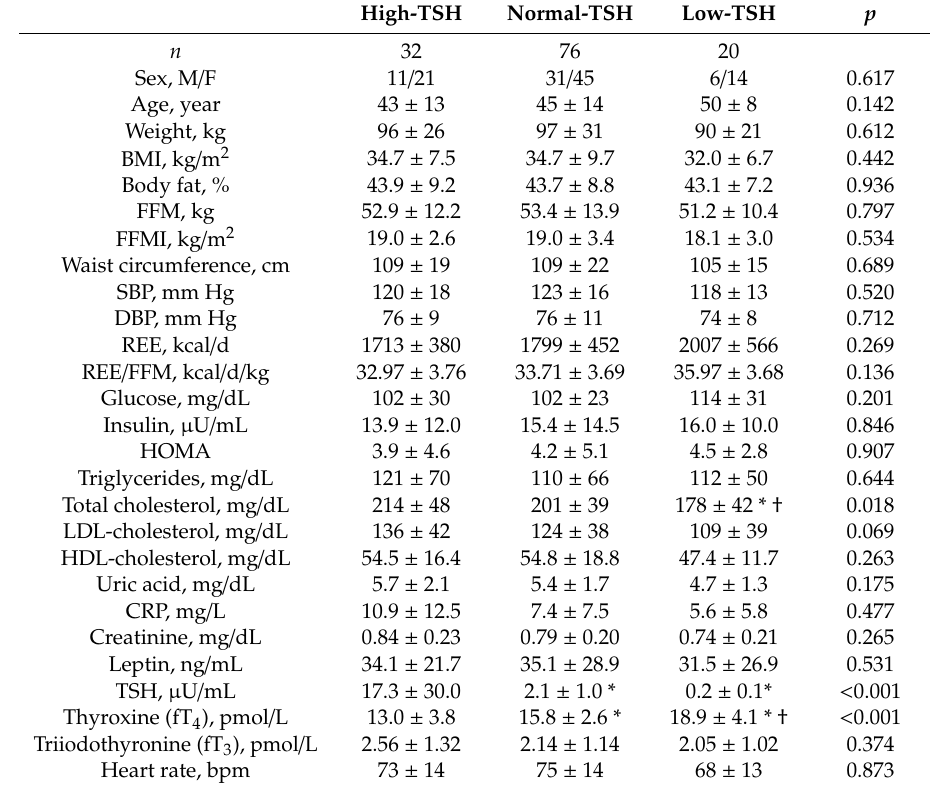
Table 4. Demographic, biochemical, and metabolic characteristics of the individuals classified according to TSH circulating concentrations.